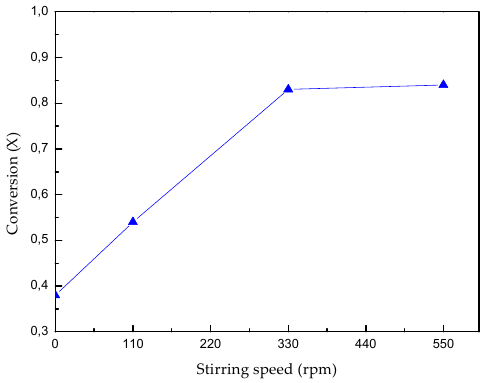
Figure 4. Effect of stirring speed on the dissolution of the mineral.